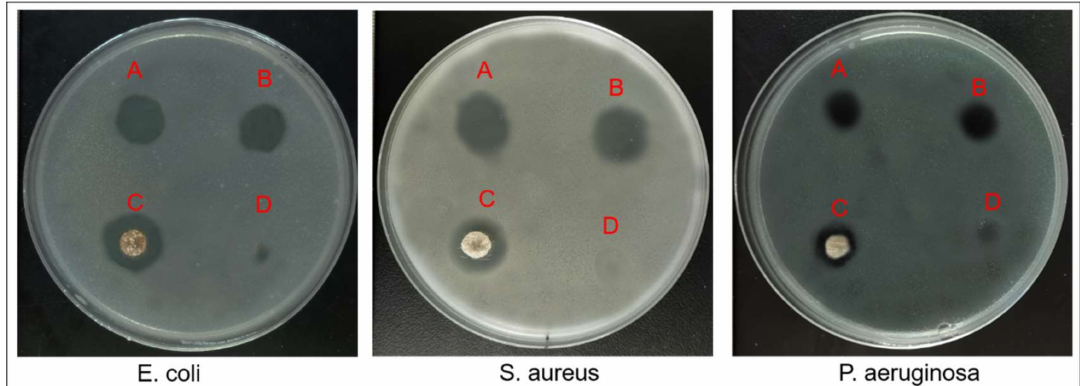
Figure 11. Inhibition effect of (A) core-shell nanofiber with drugs, (B) monoaxial nanofiber with drugs, (C) AquacelAg, and (D) core-shell nanofiber without drugs against E. coli , S. aureus , and P. aeruginosa , respectively. Table 1. Average inhibition sizes of four different samples against E. coli , S. aureus , and P. aeruginosa .